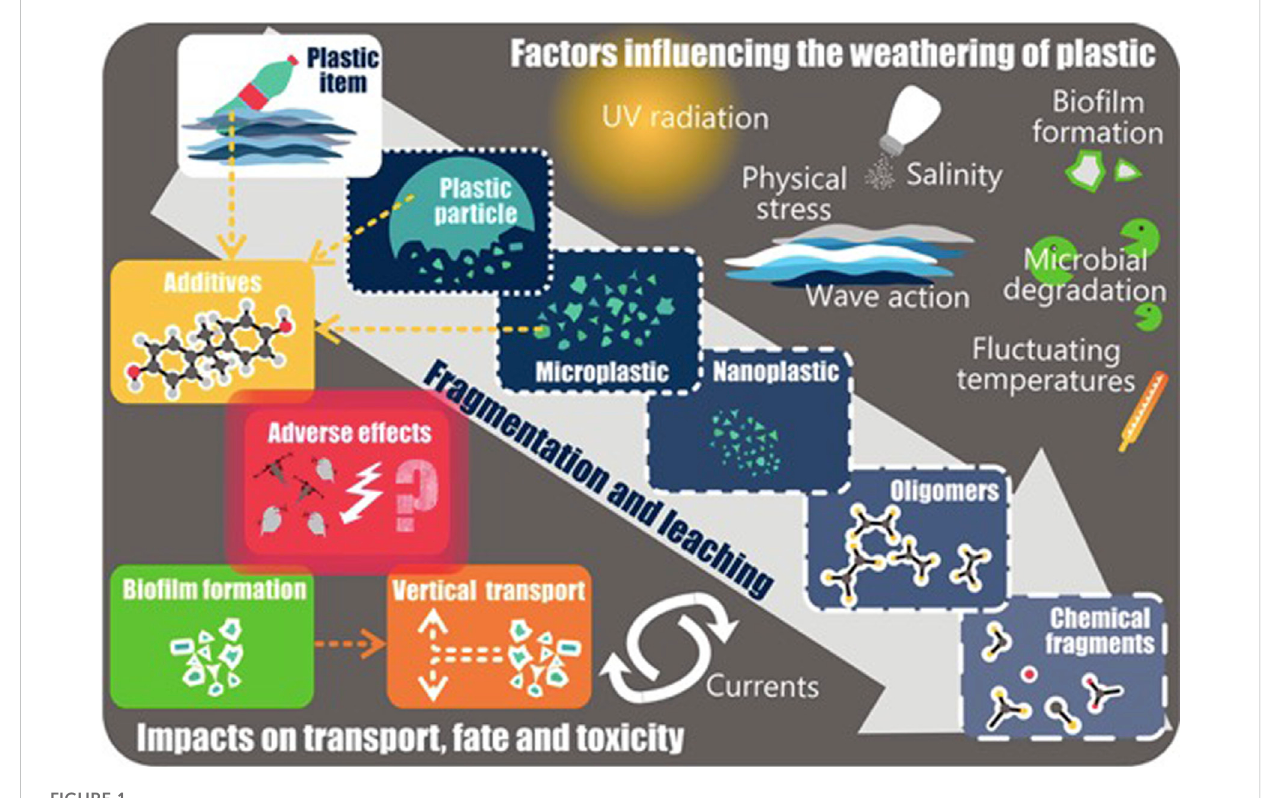
FIGURE 1 Overview of factors in fl uencing the weathering of plastics (Jahnke et al.,